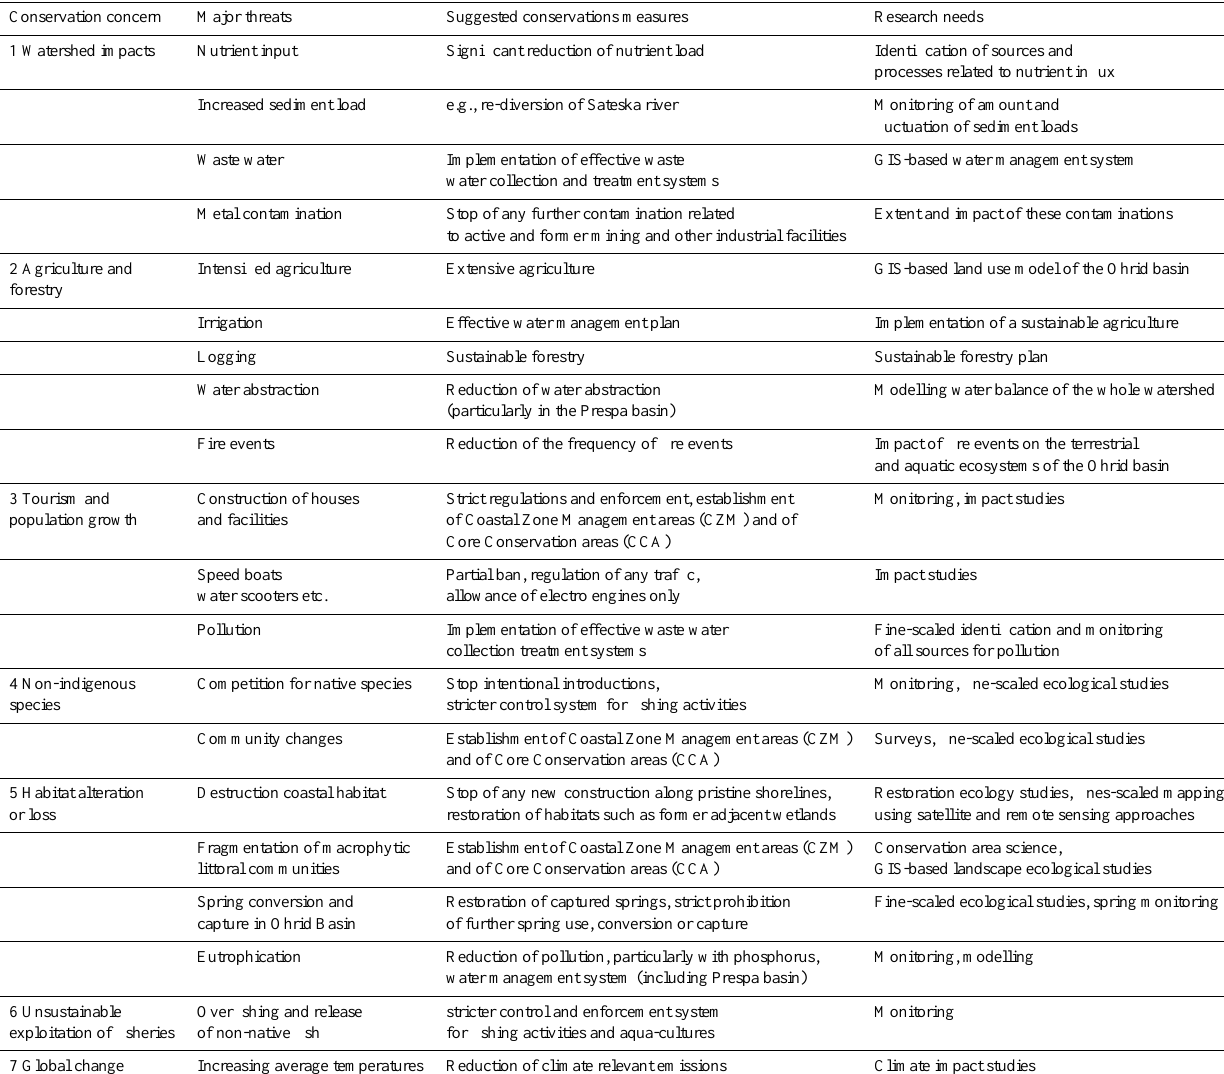
Table 3. Conservation concerns and associated major threats as well as suggested conservation and research needs for Lake Ohrid. Note that the suggested conservation measures and research needs are only examples of the most obvious needs. Most often different needs would apply for each of the mentioned major threats, which sometimes result from multiple sources. For details on the major threats identified for each concern, refer to Table